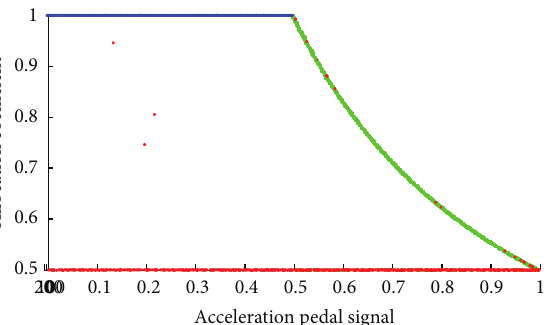
Figure 10: Design space area division.